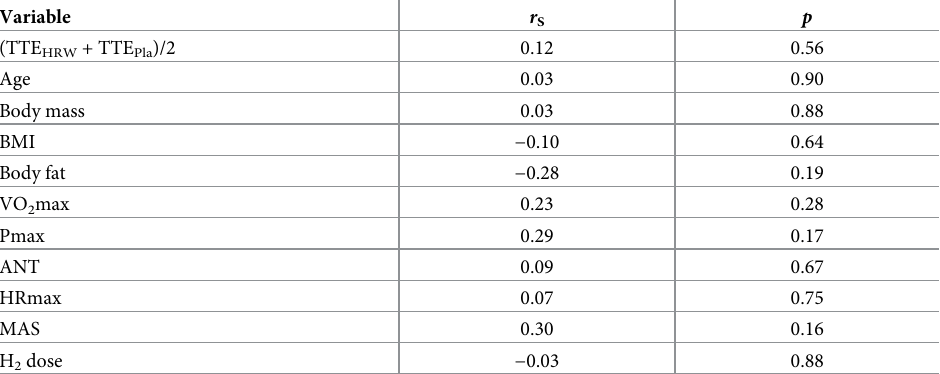
Table 4. Correlation analysis between effect of hydrogen rich water on time to exhaustion and various variables.